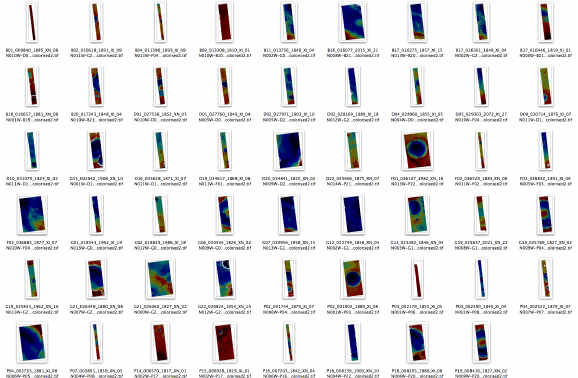
Figure 8. Example of MC11-E CTX DTM browser products. The resultant DTMs are shown in Figures 7 and 8.